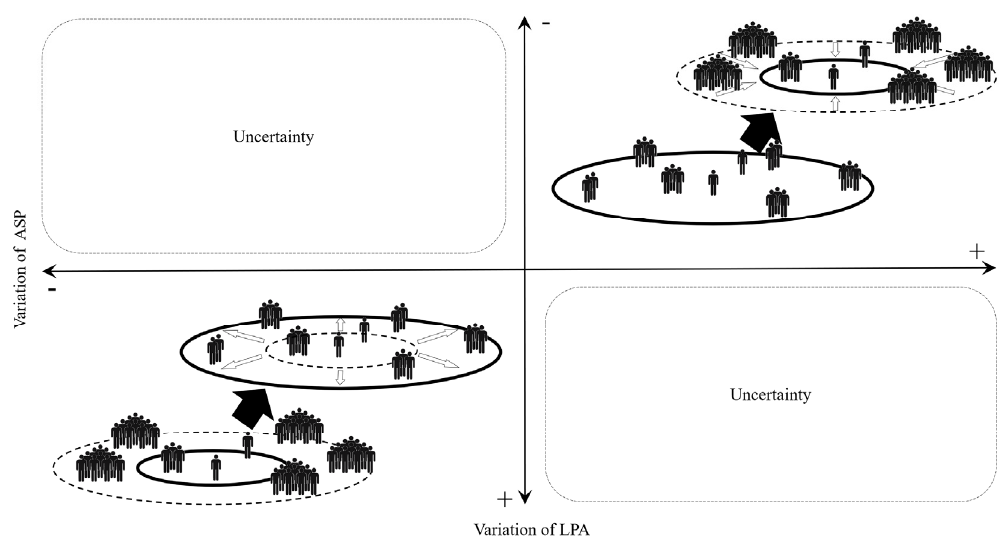
Figure 8 . Concept of spatial variation based on the difference among 2 periods. Solid circles denote areas within ASP.